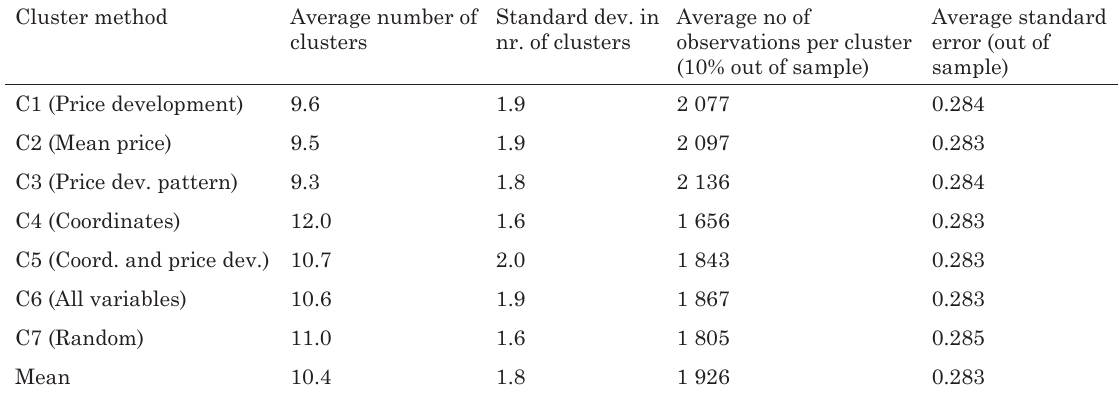
Table 5. Comparison of different clustering methods Cluster